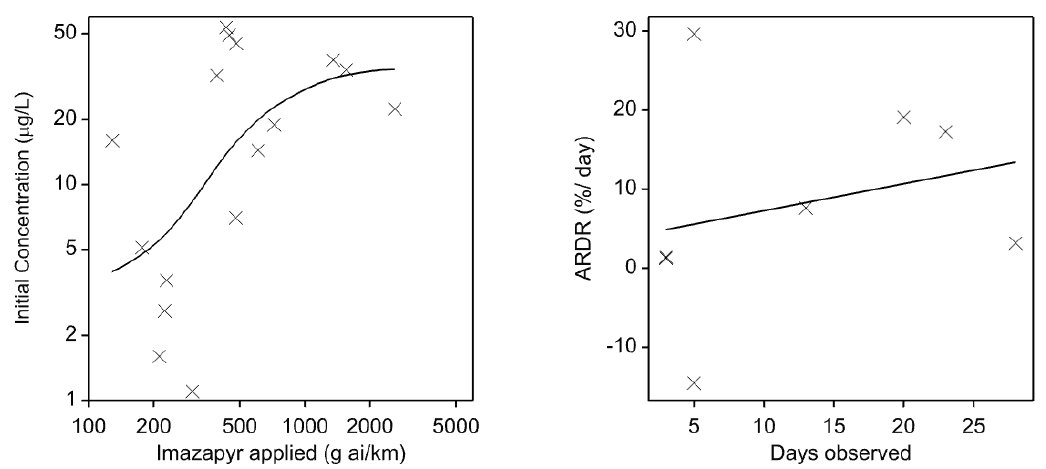
Figure 1. LEFT: Relationship between initial concentration of imazapyr in pools versus imazapyr applied. Each point represents one pool ( n = 16). Line = smoothing spline of order two. Note log scales. RIGHT: Relationship between percent average relative decay rate (ARDR%) of imazapyr during the ponding period and days observed (i.e., days between first and last sample in the ponding period). Line = smoothing spline of order one.